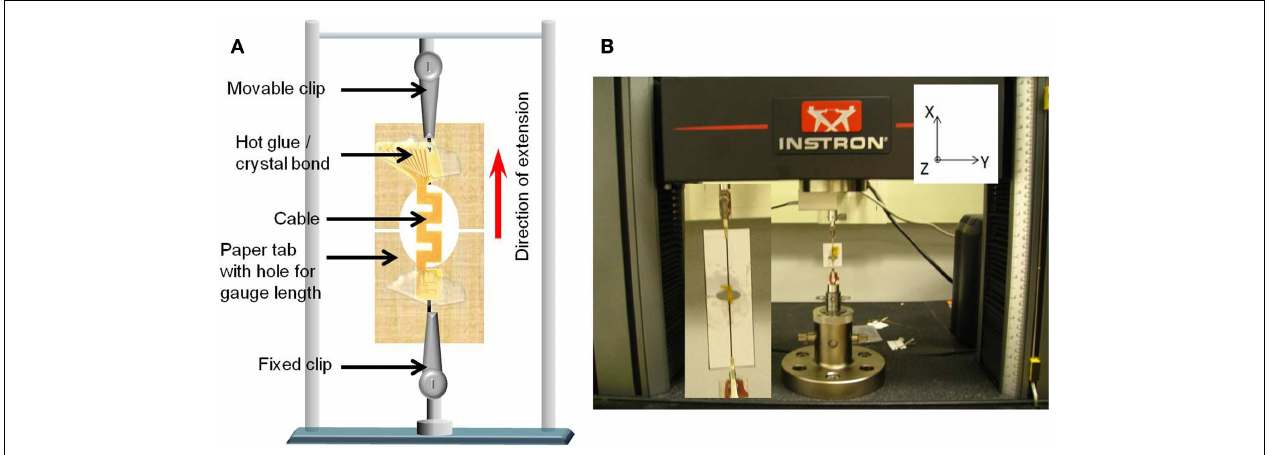
FIGURE 6 | (A) Schematic diagram of the paper mounted cable suspended between the two vertical clips connected to the load cells and (B) photograph of the cable mounted on the paper tab connected to the clips of the Instron® mechanical testing system. Inset shows the closer view of the mounted cable.